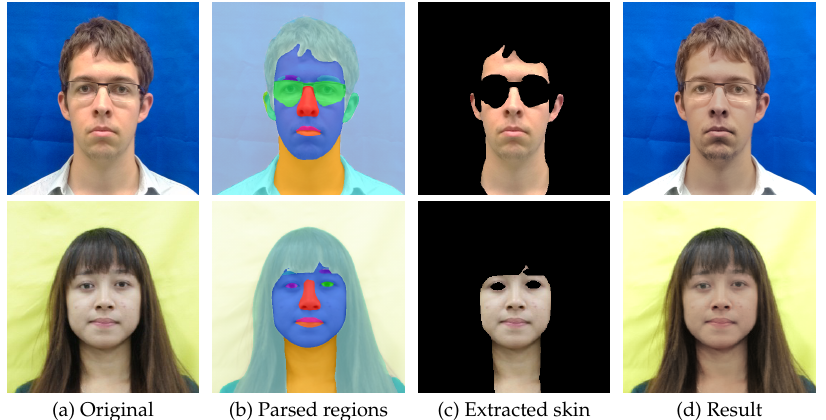
Figure 17. Good results of our method due to the skin color extraction phase. A face parsing method based on BiSeNet [16] is used. The target image is the image used in Figure